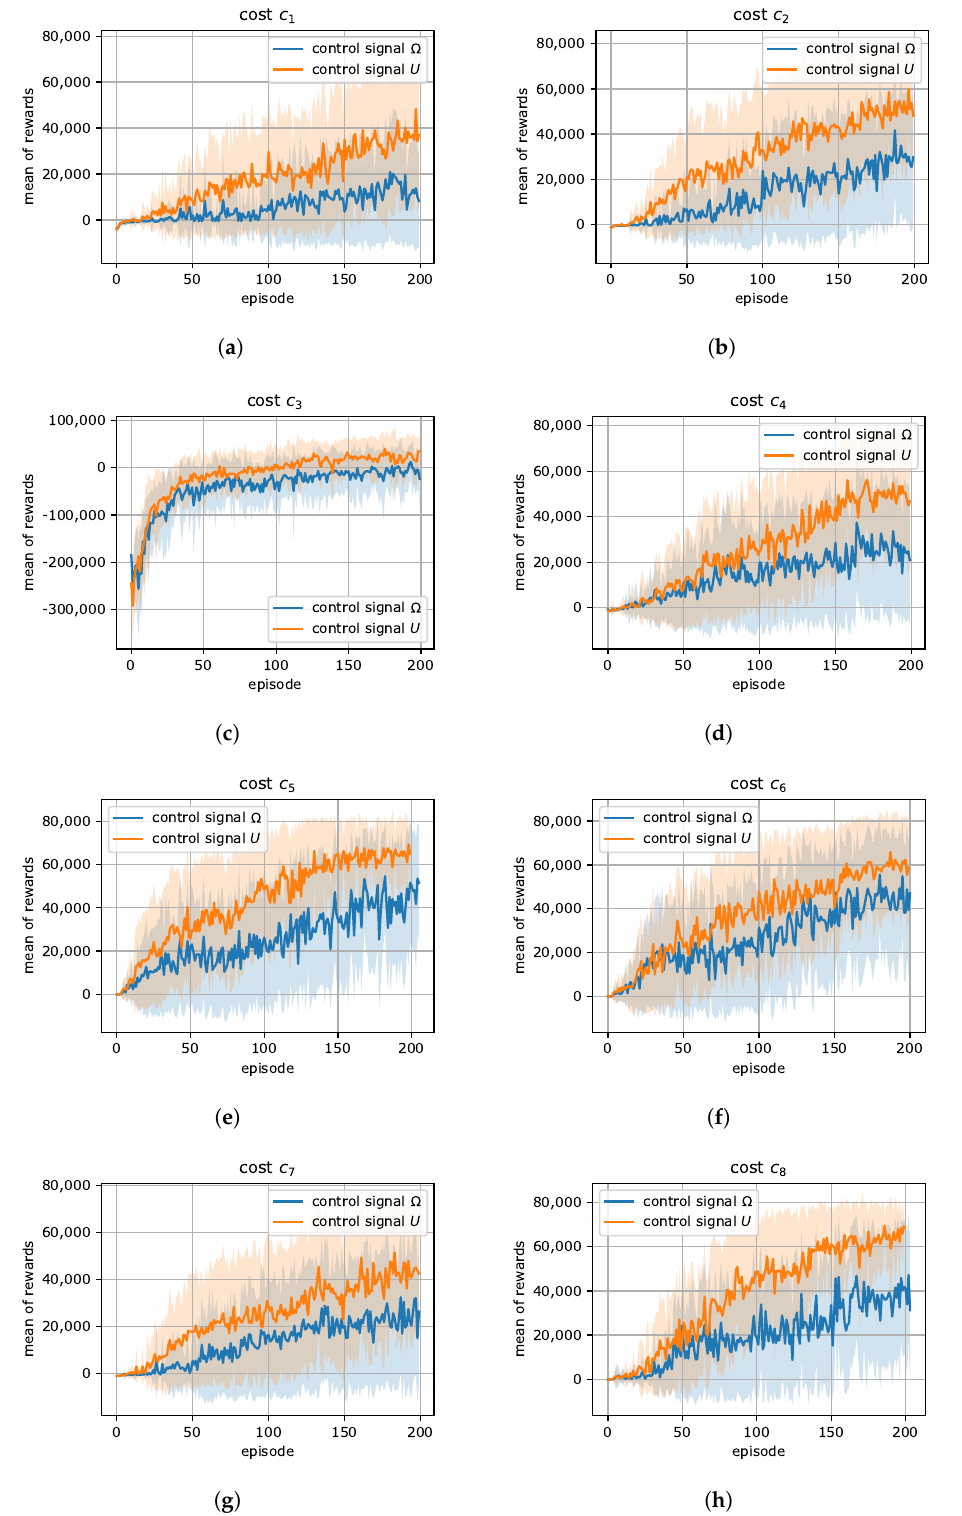
Figure 8. The mean of rewards in the episode for control signals ( Ω and U ) and all cost types ( a – h